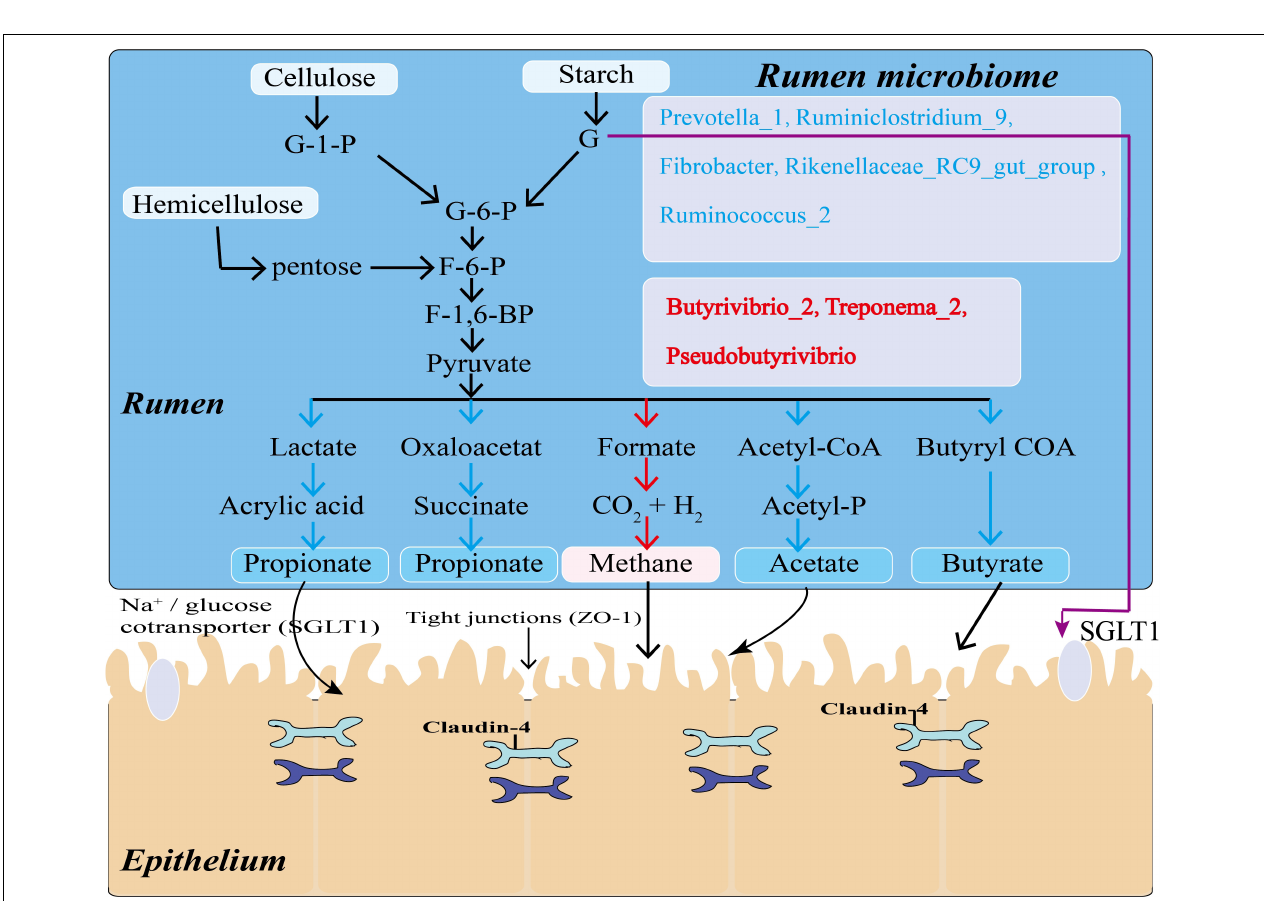
FIGURE 8 | Model of mechanisms for generation and partial absorption of VFAs in Tibetan sheep. Microorganisms in blue and red lettering act on the pathways marked by blue and red arrows, respectively.